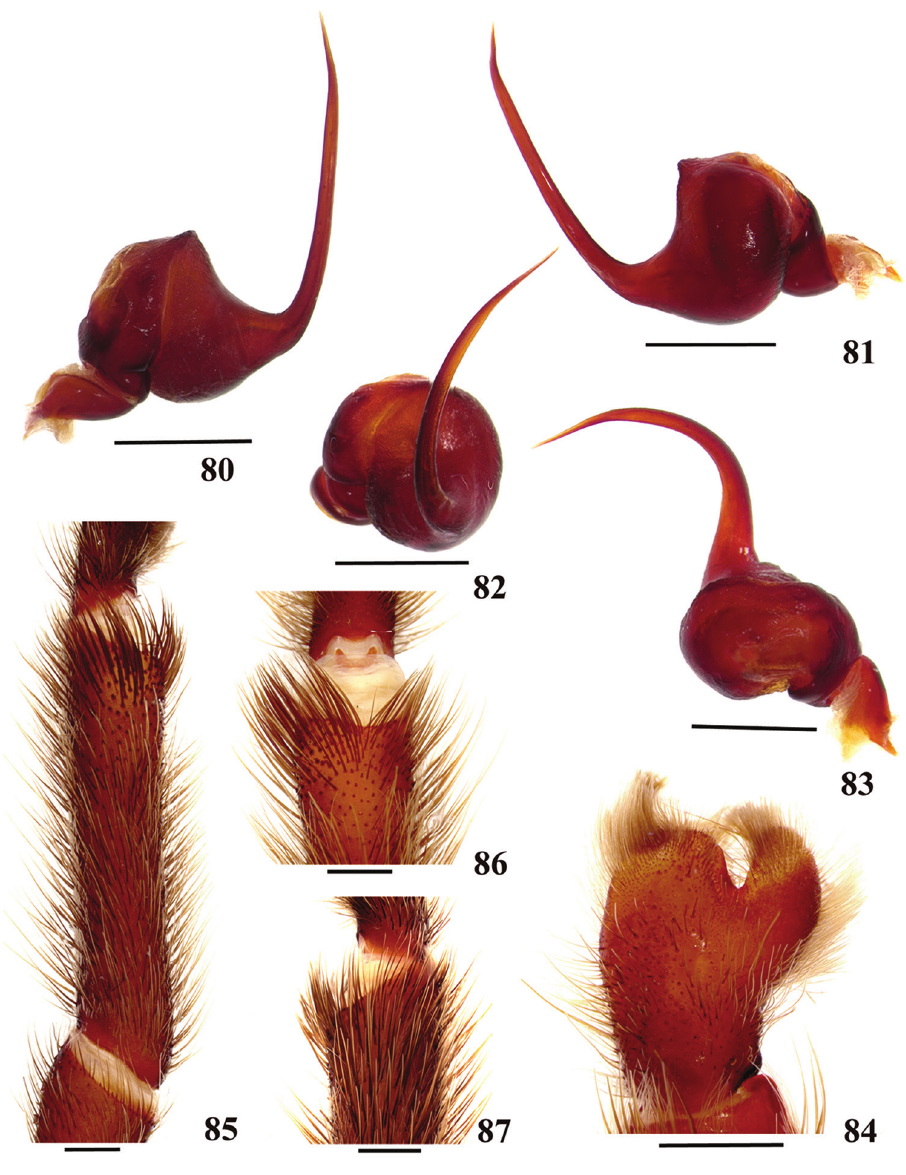
(mirrored) 80 prolateral 81 retrolateral 82 frontal 83 dorsal 84 right cymbium, dorsal (mirrored) 85–87 left tibia I 85 prolateral 86 ventral 87 retrolateral. Scale bars = 1 mm.